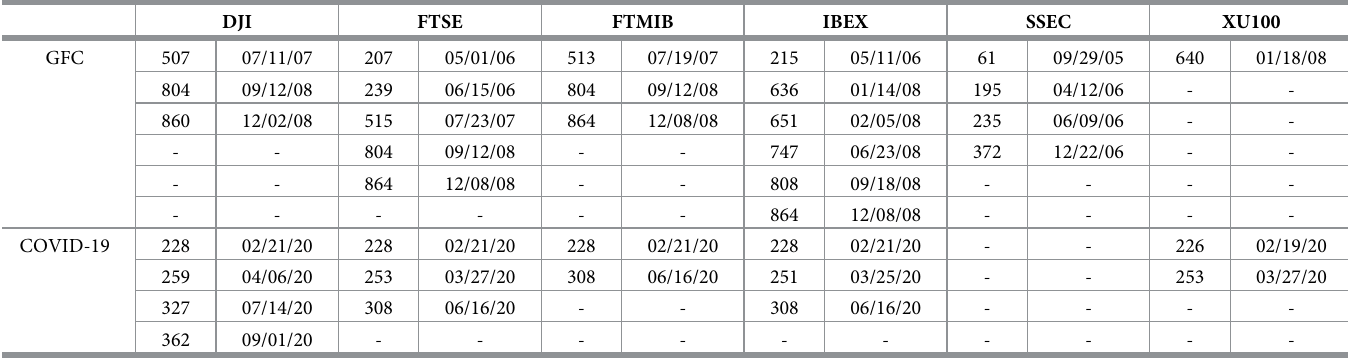
Table 3. Modified ICSS test